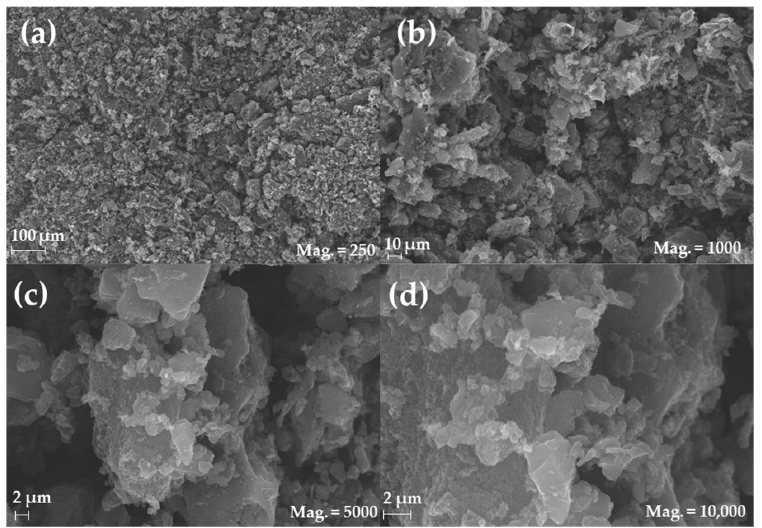
Figure 3. SEM images of 5% Ru/C with magnifications from 250 to 10,000, ( a – d ). All images were taken with following parameters: EHT = 20.0 kV, WD = 8.5 mm, SingalA = InLens. The SEM images of the Ir/C catalyst show an even distribution of particles with non-uniform shapes and a uniform size distribution. The particles were in the range of 9–25 µm. At higher magnifications, it can be seen that the surface of particles with lengths of 25–32 µm and widths of 14 µm is rough. These rough patches are similar in appearance to craters at magnifications of 50,000 and 100,000. The dimensions of these crater-like 4d).